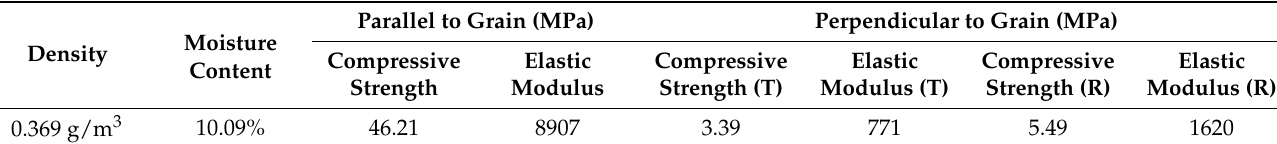
Table 3. Mechanical properties of the wood.